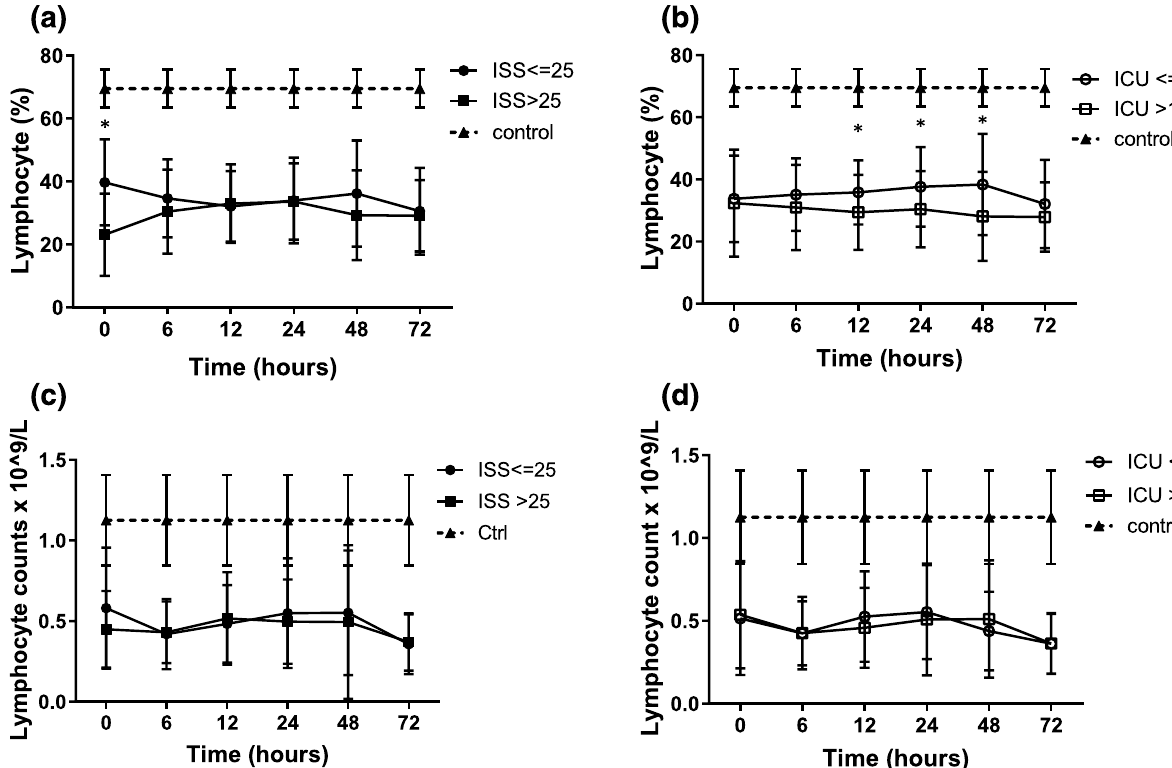
Figure 4. Trauma patients had lymphopenia compared to control ones. ( a,c ) Lymphocytes in trauma patients grouped by ISS. ( b ) The percentage of lymphocytes was significantly reduced in the patients with a long ICU stay compared to those with a short ICU stay. ( d ) The absolute numbers of lymphocytes between patients grouped ICU stay, * p <